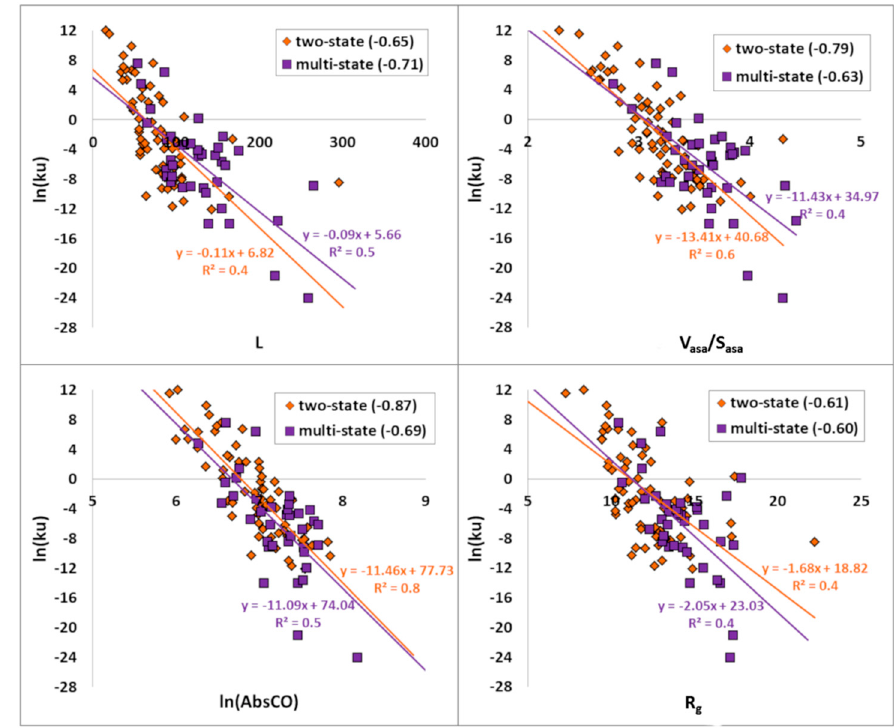
Figure 2. Correlations of the logarithm of the unfolding rates of 108 proteins with their structural parameters: L—length of the protein, V asa / S asa —radius of the cross-section, ln(AbsCO)— logarithm of the absolute contact order, and R g (radius of gyration). There is a line approximation of points and its equation: orange line corresponds to two-state proteins and purple line to multi-state proteins. R 2 is a linear approximation reliability.